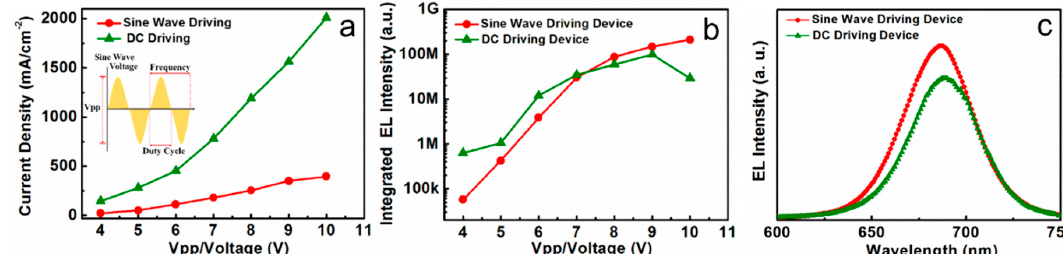
Figure 3. ( a ) Density-voltage curve of the CsPbI 3 QDs light-emitting diodes (LEDs) under DC and AC (sine pulsed bias, duty cycle: 50%, frequency: 10 Hz) driving conditions. The inset is a schematic diagram of the sine pulsed bias; ( b ) Integrated electroluminescent (EL) intensity of CsPbI 3 QDs LEDs versus voltage under DC and AC driving conditions (sine pulsed bias, duty cycle: 50%, frequency: 10